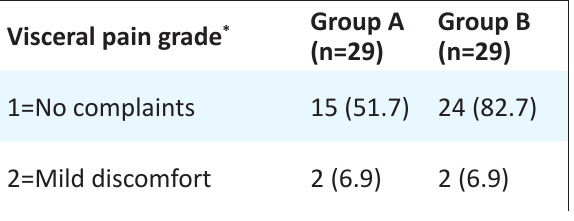
Table 3. Severity of visceral